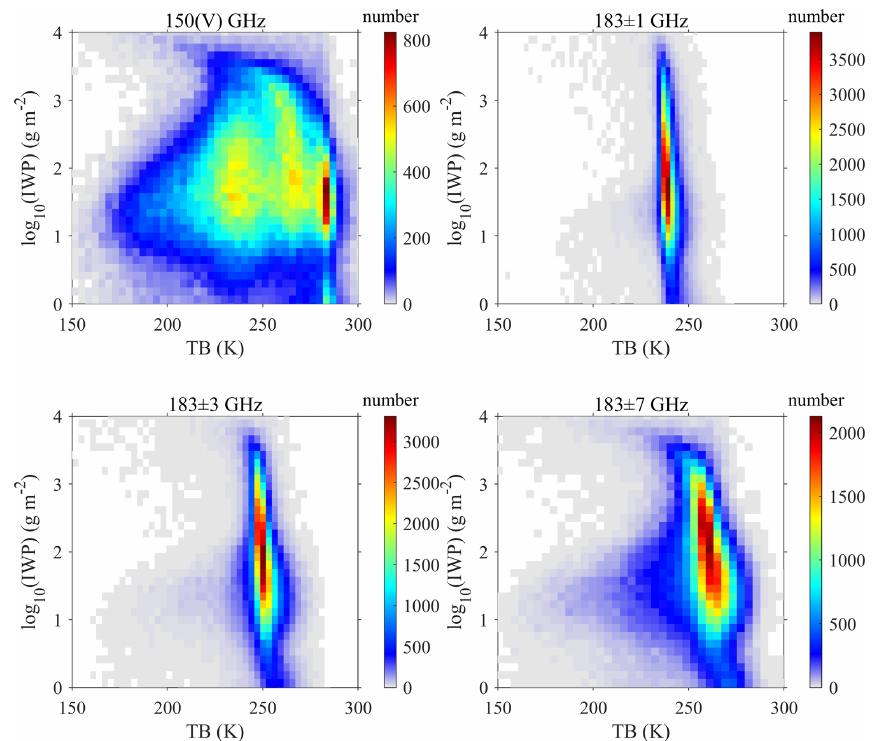
Figure 4. Statistical information of TB and IWP for different